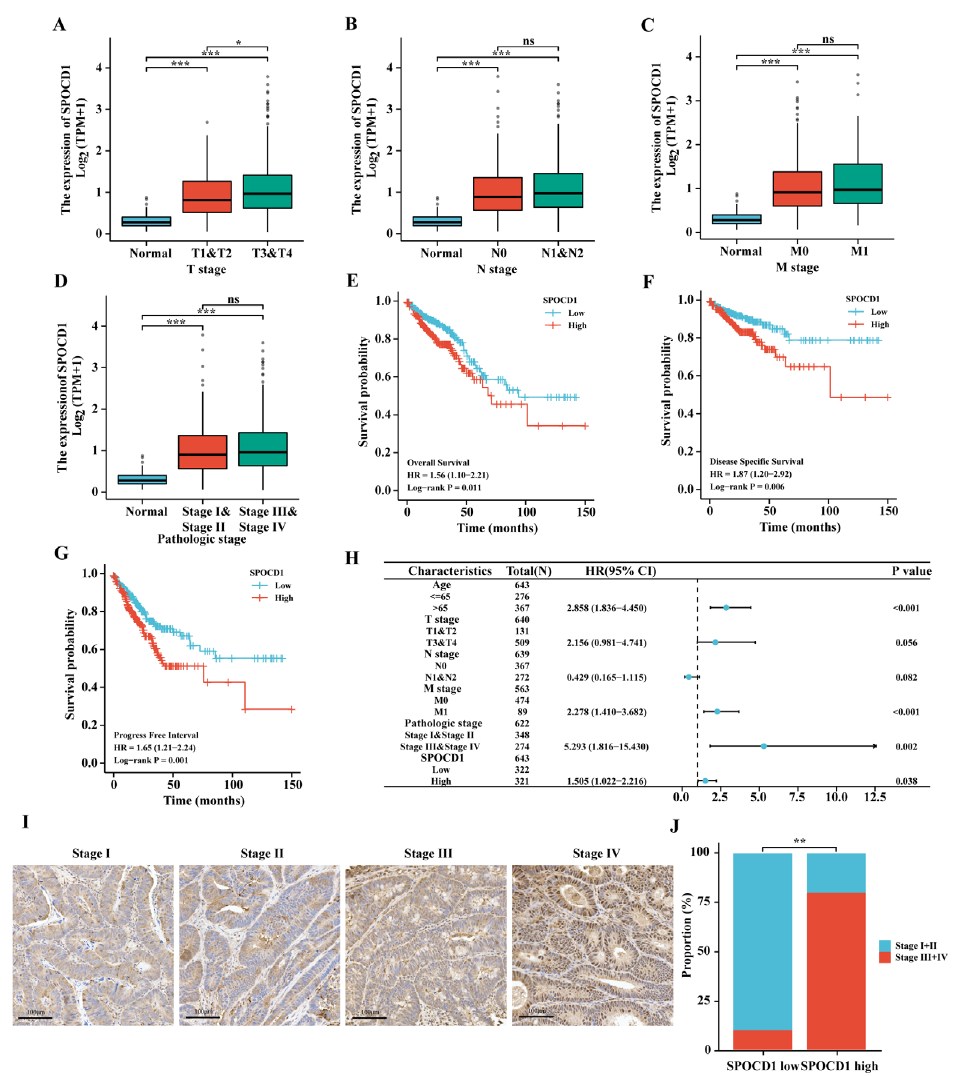
Figure 2. Associations between SPOCD1 expression and clinicopathologic characteristics and its prognostic significance in CRC based on TCGA database. SPOCD1 expression was significantly as- sociated with T stage ( A ) but not with N stage ( B ), M stage ( C ), and pathological stage ( D ). ( E – G ) The Kaplan-Meier curves show that CRC patients with a higher expression of SPOCD1 had a shorter overall survival time, disease-specific survival time, and progress-free interval time. ( H ) Multivari- ate Cox analyses of factors affecting the overall survival of CRC patients in the TCGA database. ( I ) immunohistochemistry (IHC) staining showing SPOCD1 protein expression in CRC samples of the different pathological stages. ( J ) Stacked histogram shows the proportion of CRC at different stages in the high and low SPOCD1 expression groups. (ns represents no significance, * p < 0.05, ** p < 0.01, *** p < 0.001). Table 1. The correlation of clinicopathological characteristics and SPOCD1 expression. Characteristic